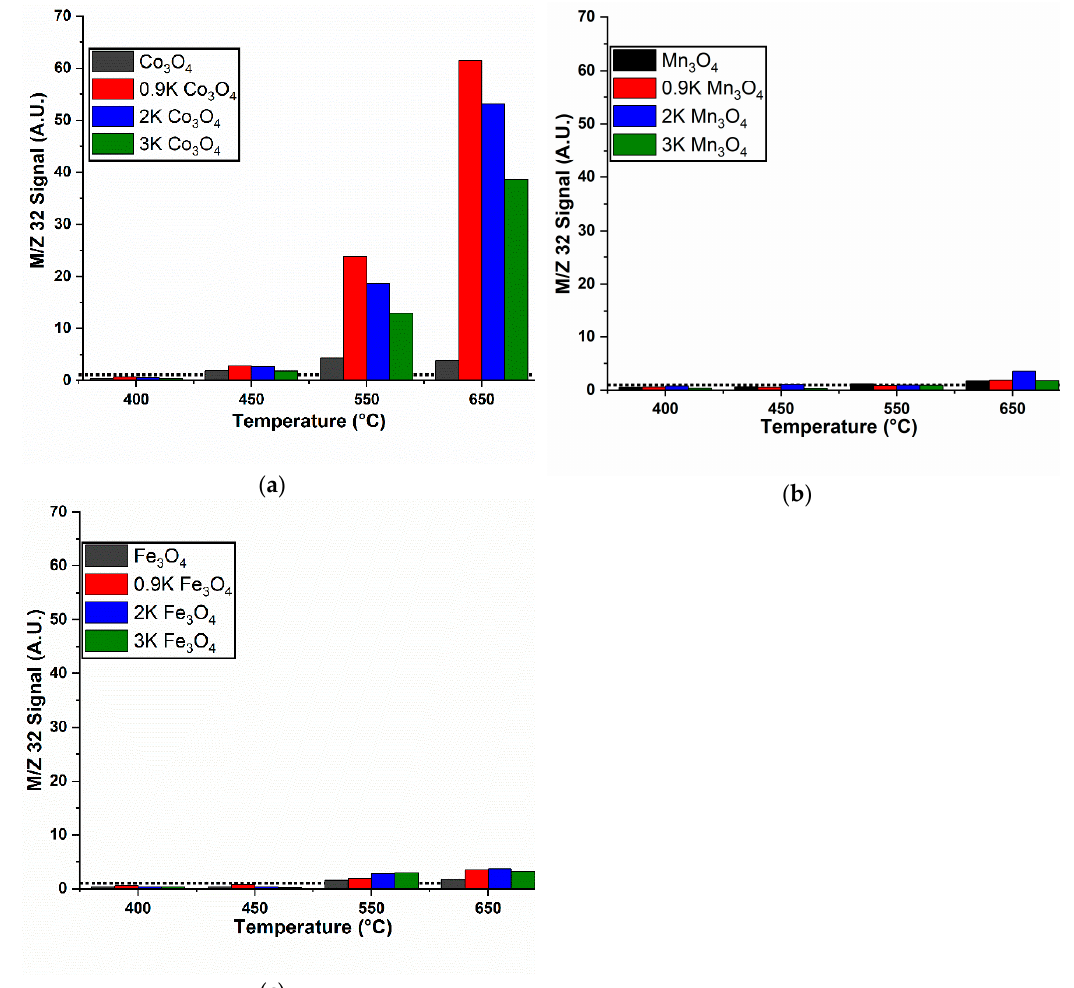
Figure 5. The O 2 mass spectrometer (MS) signal intensity (m/z = 32) during isothermal NO decomposition at 400, 450, 550, and 600 °C over: ( a ) Co 3 O 4 -based catalysts, ( b ) Mn 3 O 4 -based catalysts, and ( c ) Fe 3 O 4 -based catalysts. The baseline m/z = 32 signal is indicated with a dashed line, and data are normalized to set the baseline value to unity.